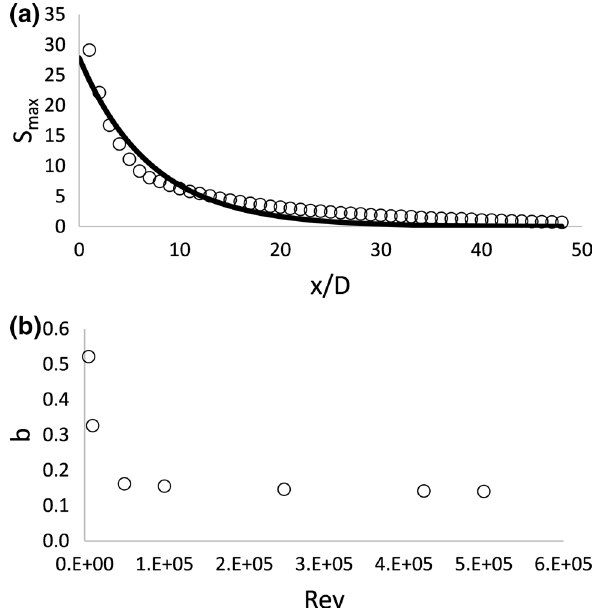
Fig. 8 a Decay of maximum swirl angle along straight pipe after elbow for Setup 2 and Rey = 500,000, (◌) our results, (line) Eq. 4. b Decay rate b (see Eq. 4) in function of Reynolds number for Setup 2